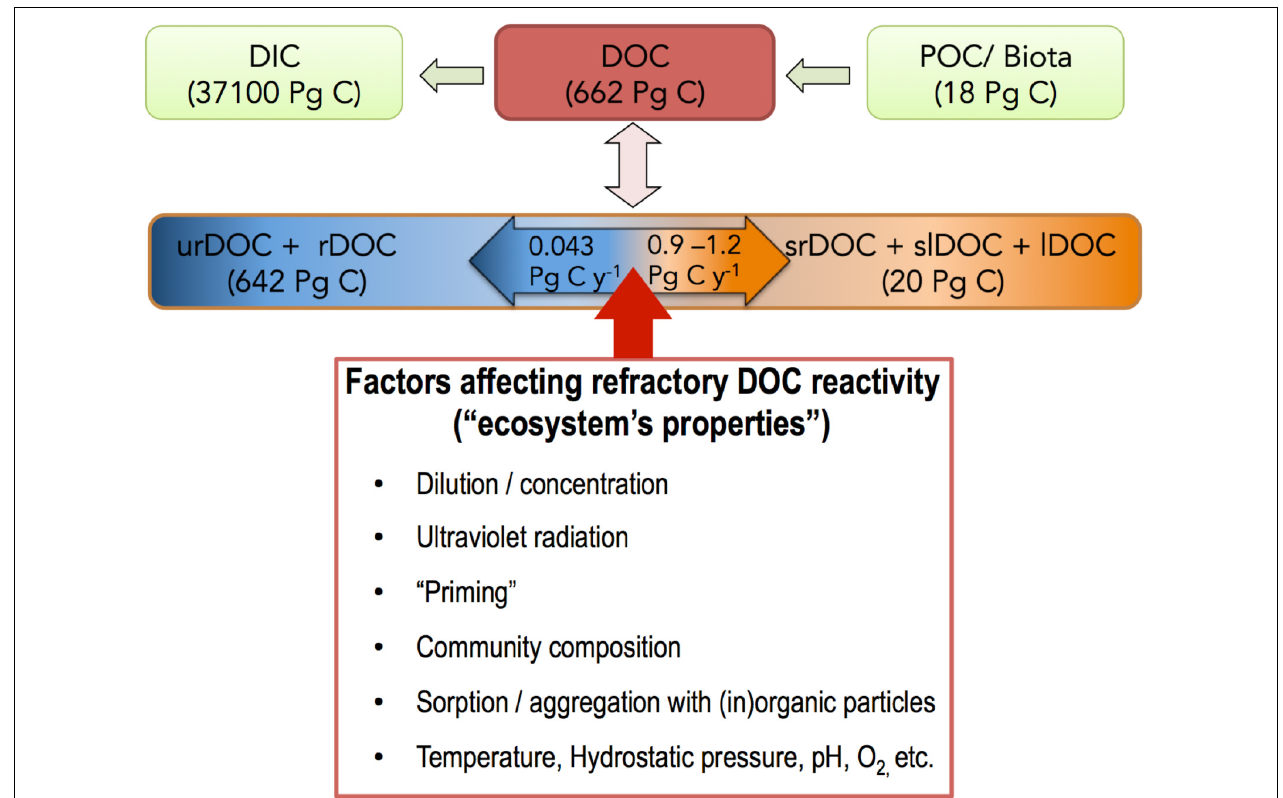
FIGURE 1 | Diagram showing major carbon stocks in the ocean, including a list of the main factors affecting reactivity of the refractory (rDOC) pool. The DOC inventory in the global ocean is ca. 662 Pg C (Hansell, 2013). The POC/marine biota pool is ca. 18 P g C, including 1–3 Pg C phytoplankton, 0.1 Pg C zooplankton, 0.1 Pg C bacteria and 15 Pg C of detritus (Perdue and Benner, 2009). Short-lived DOC has a pool size of about 20 Pg C (662–642 Pg C). DIC: dissolved inorganic carbon, DOC, dissolved organic carbon; POC, particulate organic carbon; urDOC, ultra-refractory DOC; rDOC, refractory DOC; srDOC, semi-refractory DOC; slDOC, semilabile DOC; lDOC, labile